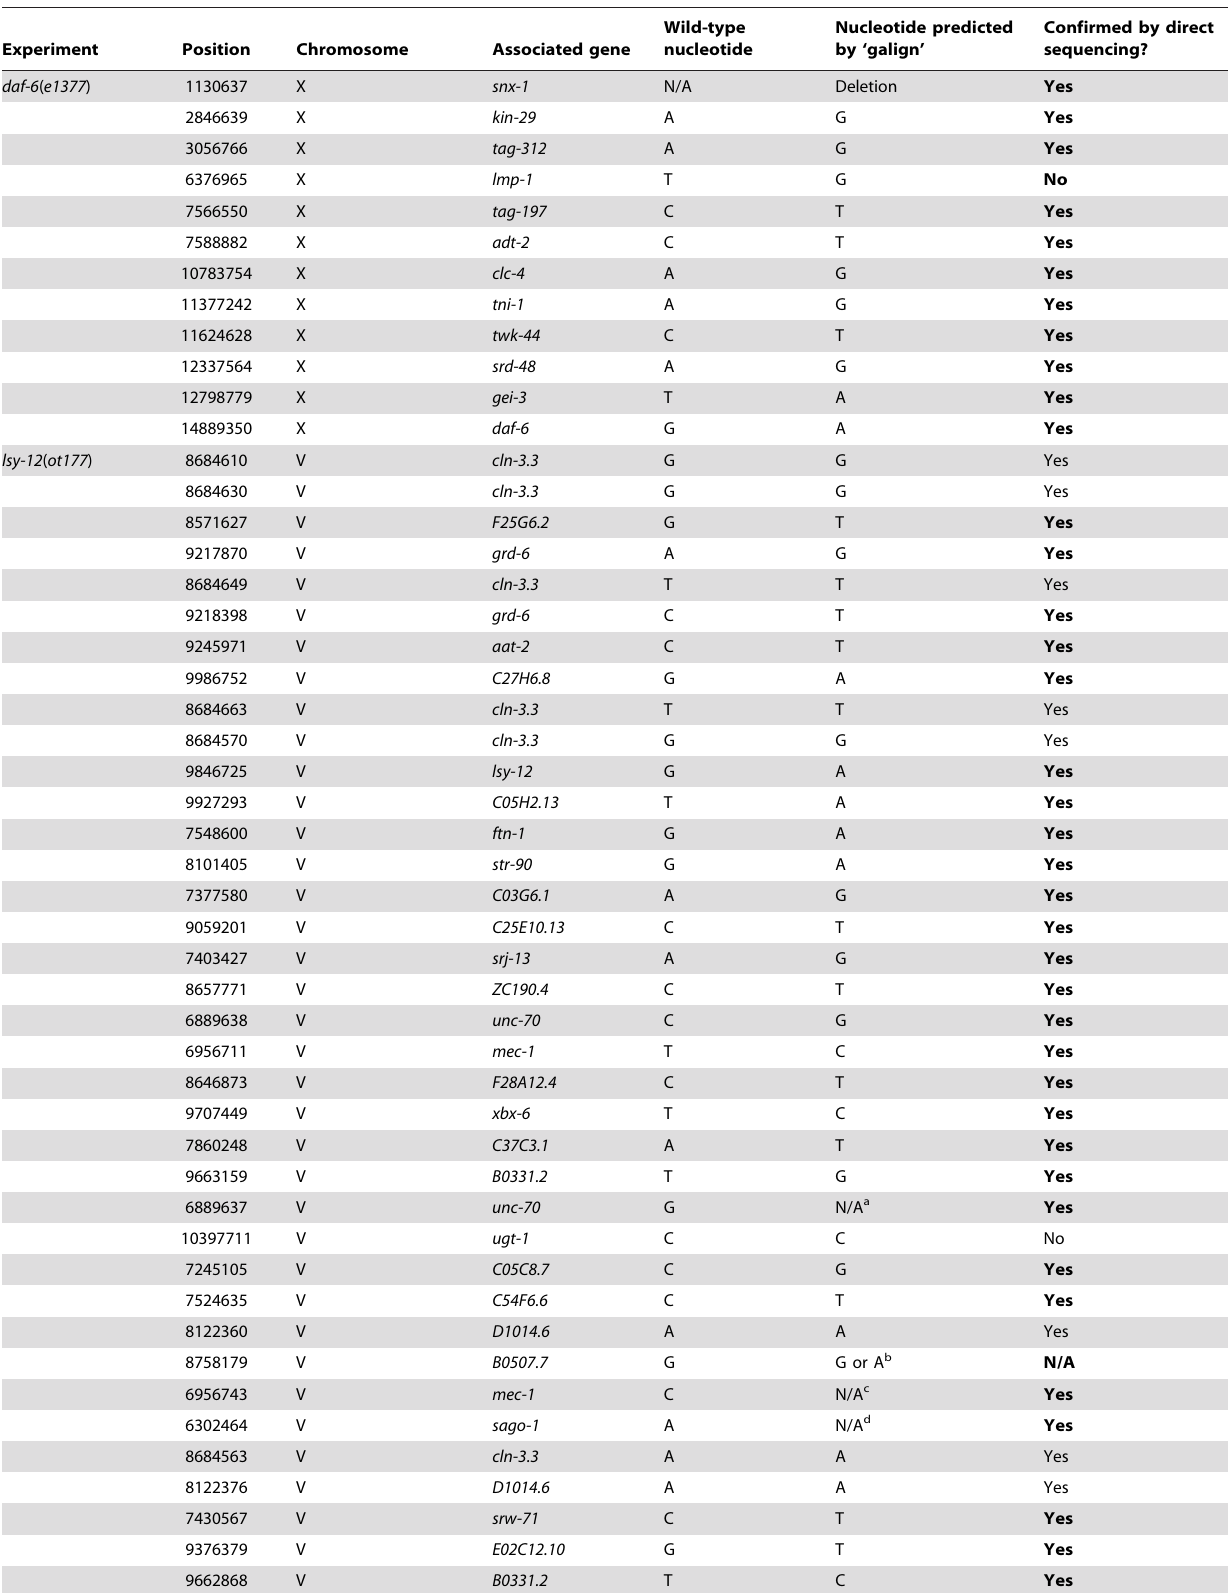
Table 1. Assessing ‘galign’ predicted polymorphisms by direct sequencing.